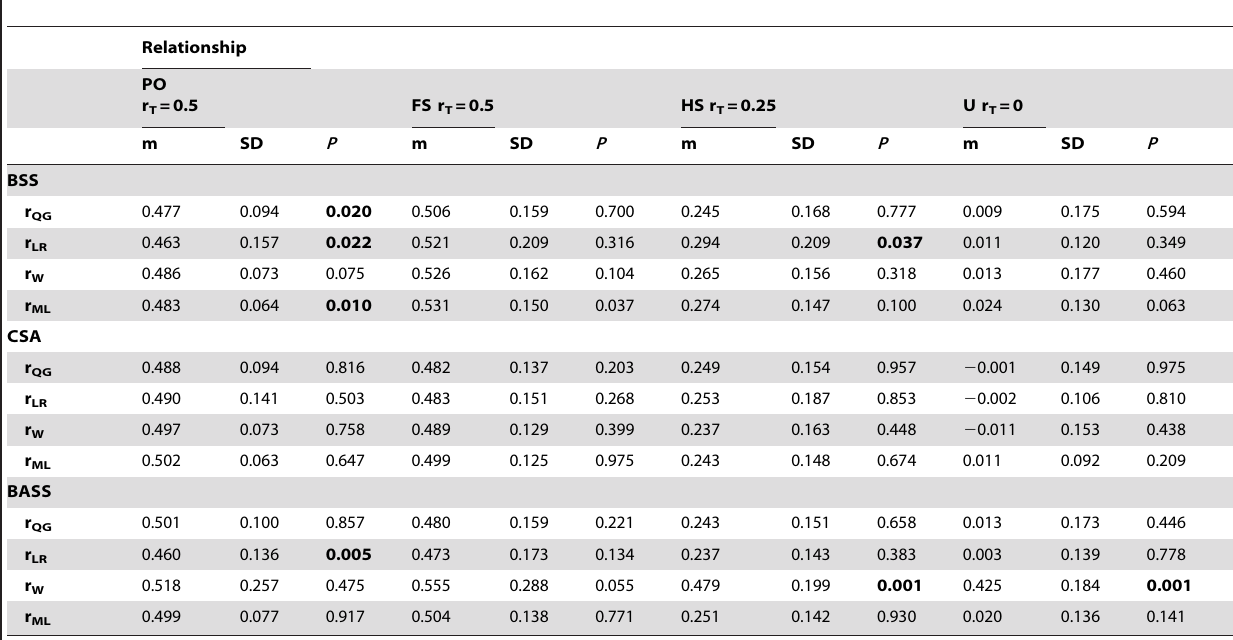
Table 2. Mean relatedness (m) and standard deviation ( SD ) for the 100 simulated pairs of individuals of each genealogical relationship, based on the BSS, CSA and BASS allele